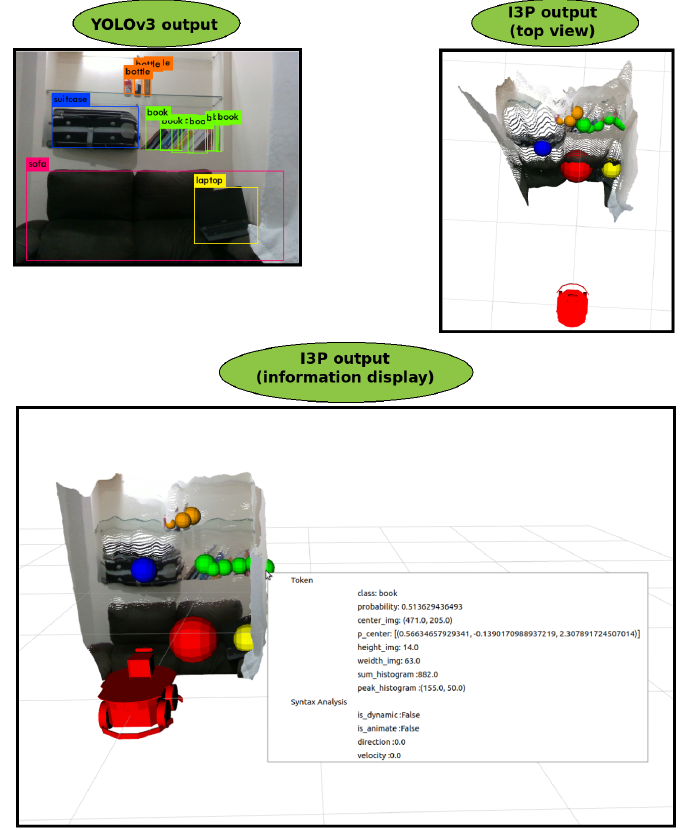
Figure 8. Result of the application of the Lexical